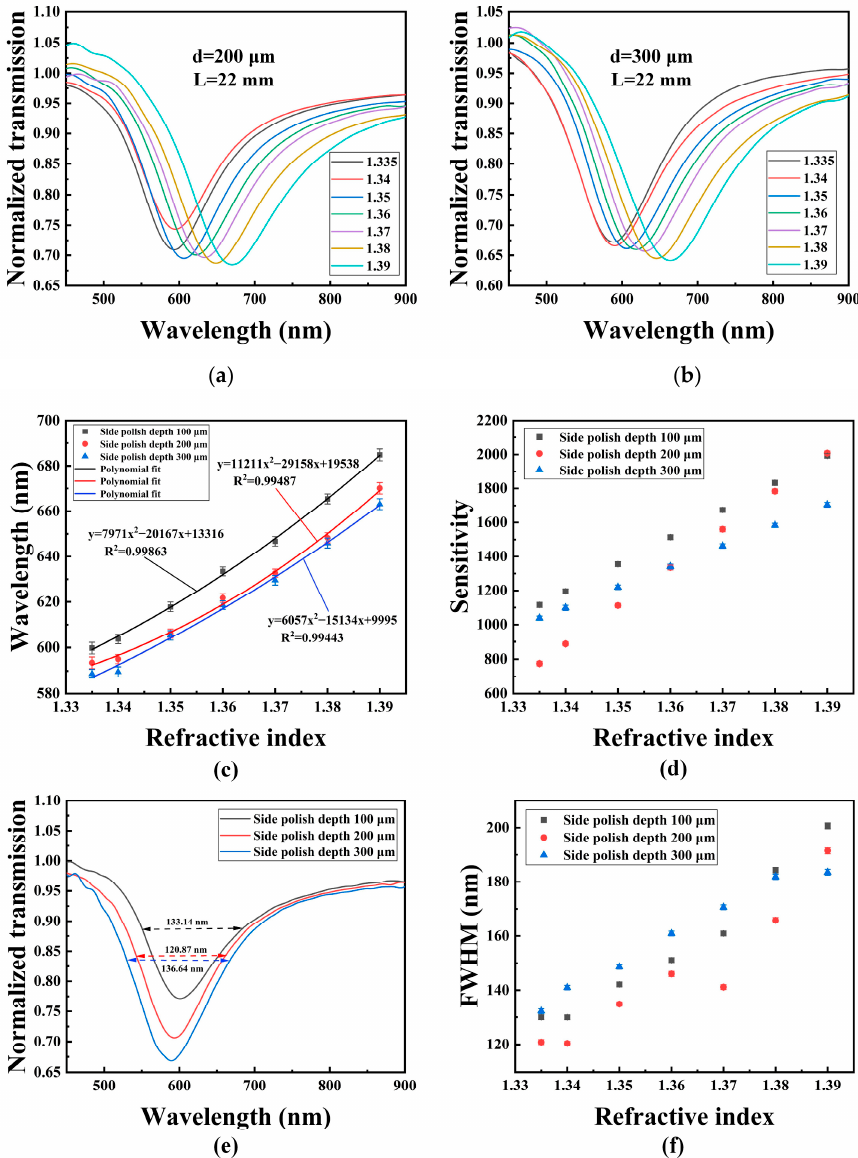
Figure 8. RI sensing performance for the POF probes with different depths: ( a ) 200 µ m; ( b ) 300 µ m; ( c ) The relationship of SPR peak wavelength and RI for probes with different polished depths; ( d ) RI sensitivity of probes with different polished depth; ( e ) Normalized transmission spectra of the POF probes with different polished depths in water; ( f ) FWHM of probes with different polished depth in different samples.